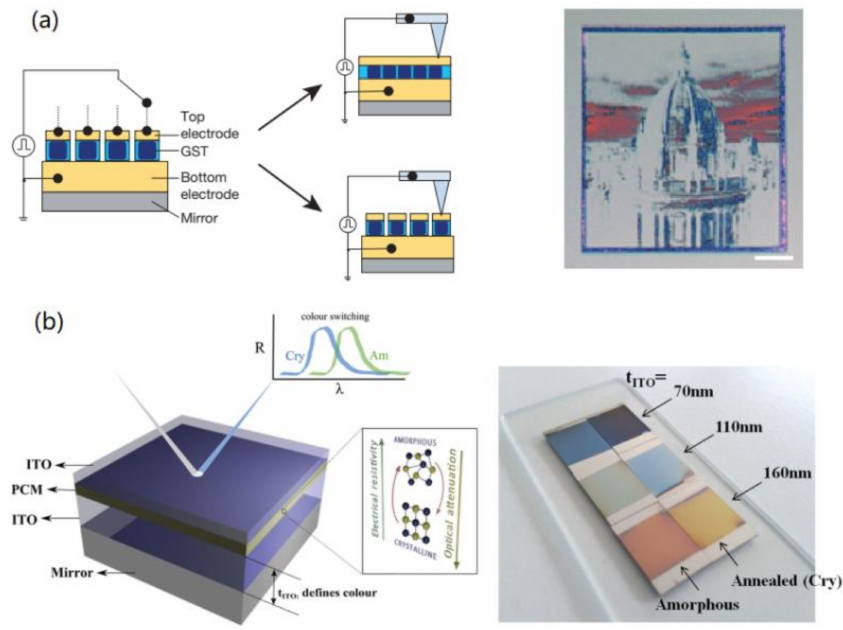
Figure 4. The pixel-wisely programmable GST/dielectric metasurface for color display: ( a , b ) repro- duced with permissions from